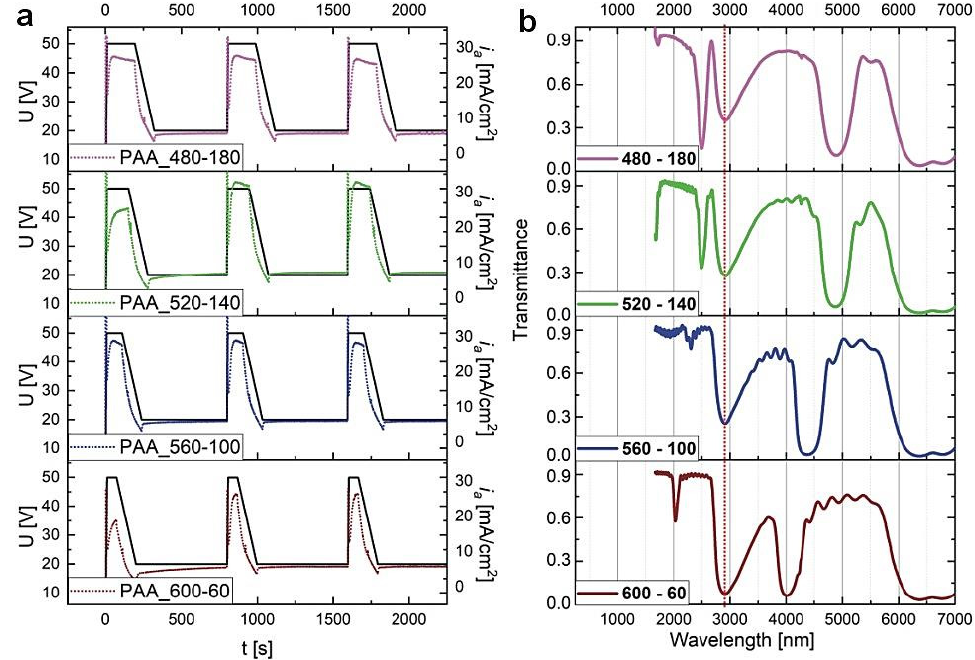
Figure 4. ( a ) The U(t) (black solid lines) i a (t) (dotted lines) curves recorded during pulse anodization at 30 °C with various t H and t L (the samples PAA_ t L -t H ) and other parameters as follows: U H = 50 V, U L = 20 V, U H ->U L drop rate = 0.234 V/s, 20 cycles; ( b ) the corresponding transmission spectra recorded for the samples, after t p = 60 min.